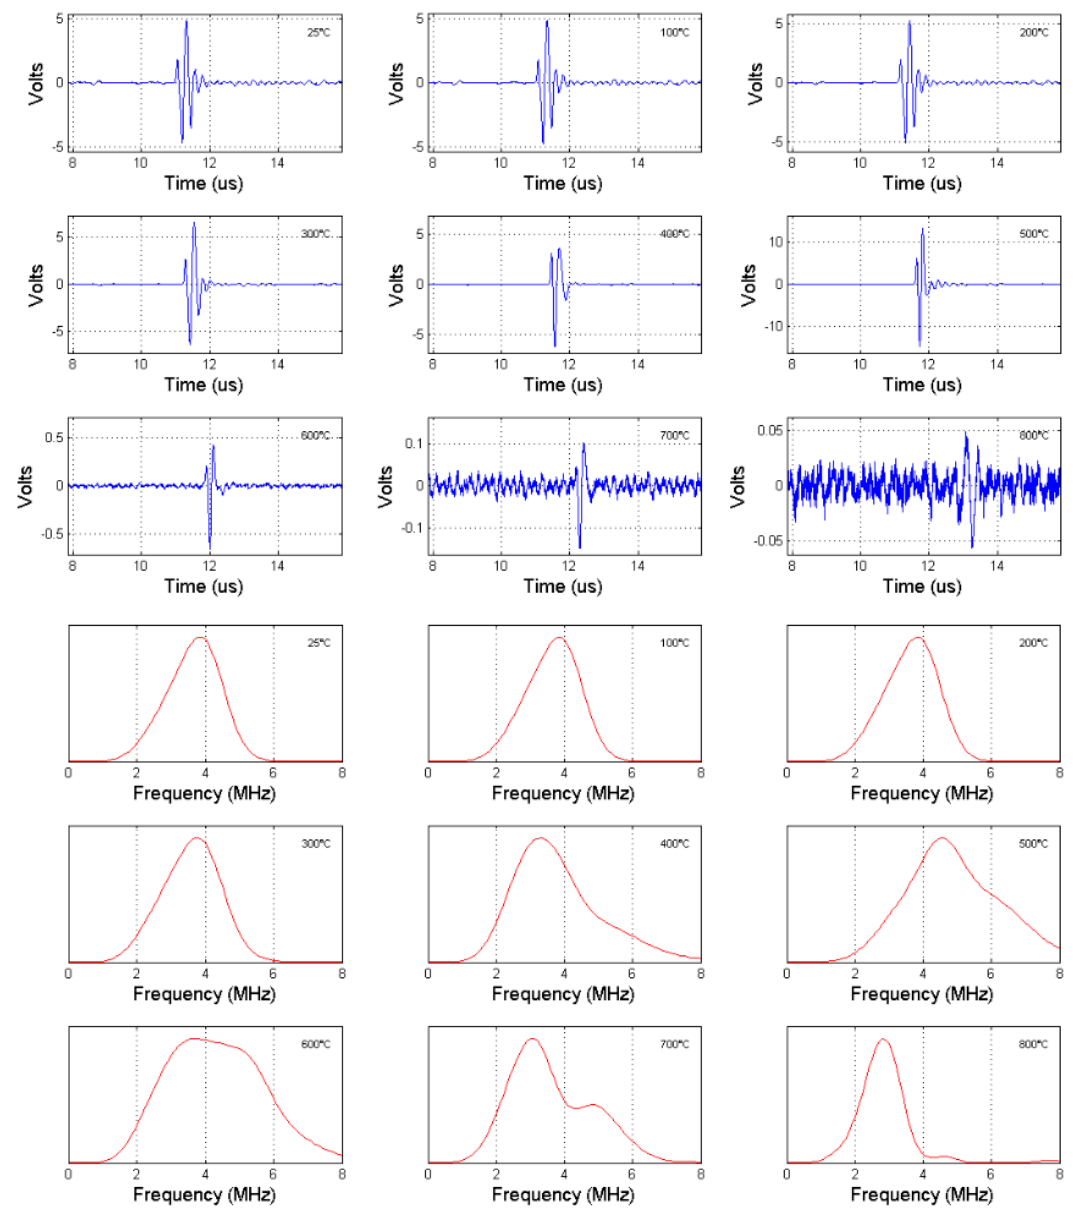
Figure 8. Ultrasound performance at elevated temperatures of LiNbO 3 and porous zirconia transducers brazed with Al-665 brazing material. Corresponding time and frequency plots are included from room temperature to 800 °C.